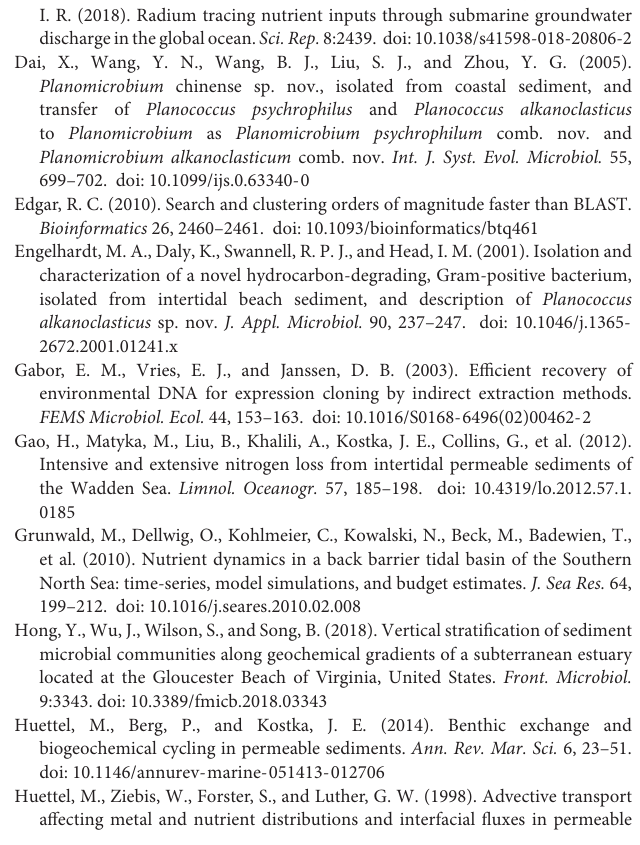
Supplementary Figure 2 | PERMANOVA of Bray-Curtis dissimilarities and physicochemical parameters; n indicates the number of samples for the respective parameter. Supplementary Table 1 | Combined physico-chemical and diversity data used for this